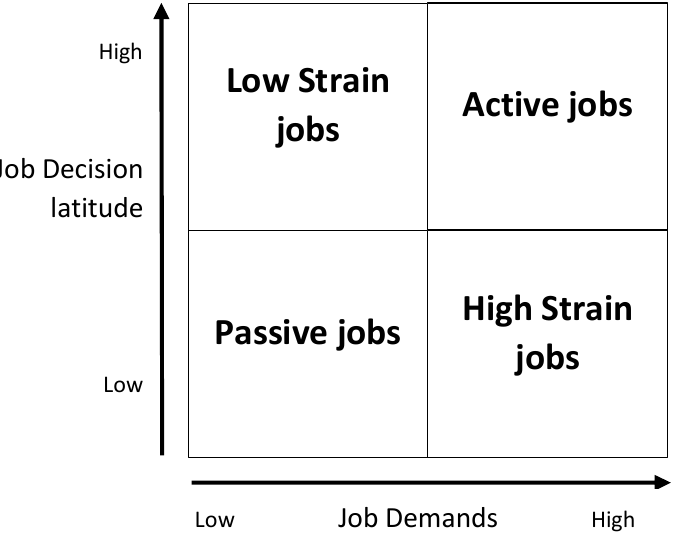
Figure 1. Job demand control model by Robert Karasek [9,10].